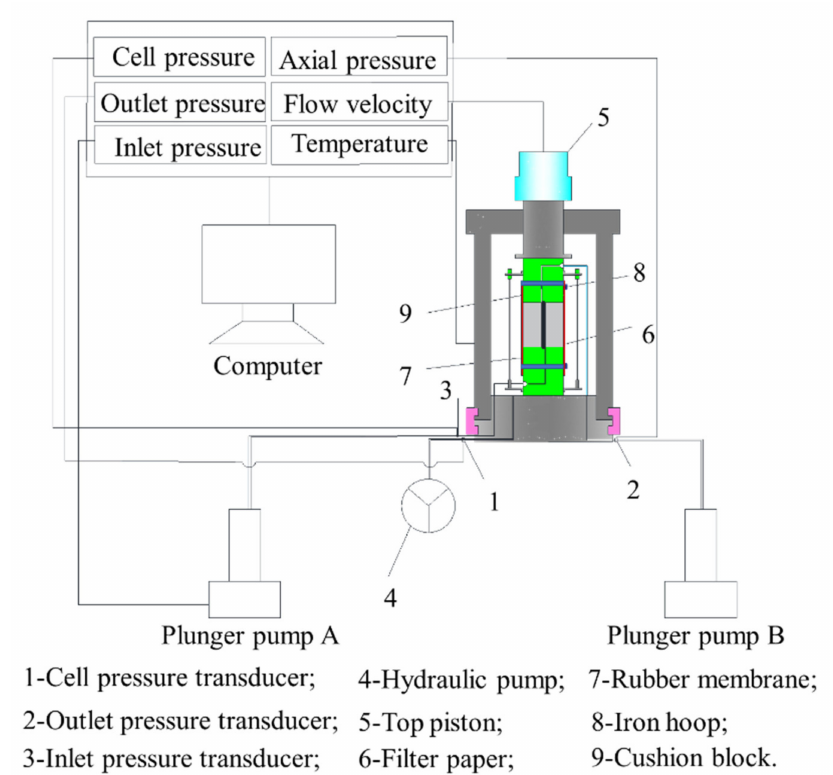
Figure 7. Schematic of experimental setup for permeability